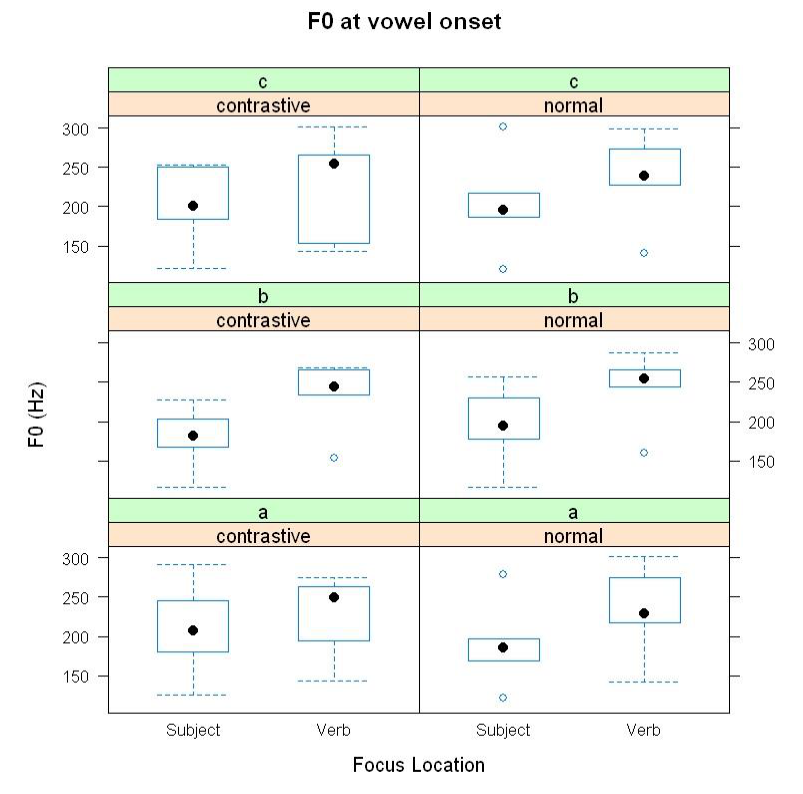
Figure 9. Boxplots of the F0-values extracted at the onset of the vowel preceding the stressed vowel within the verb (y-axis) as a function of focus location (x-axis). Results are plotted separately for focus kind (columns) and sentence